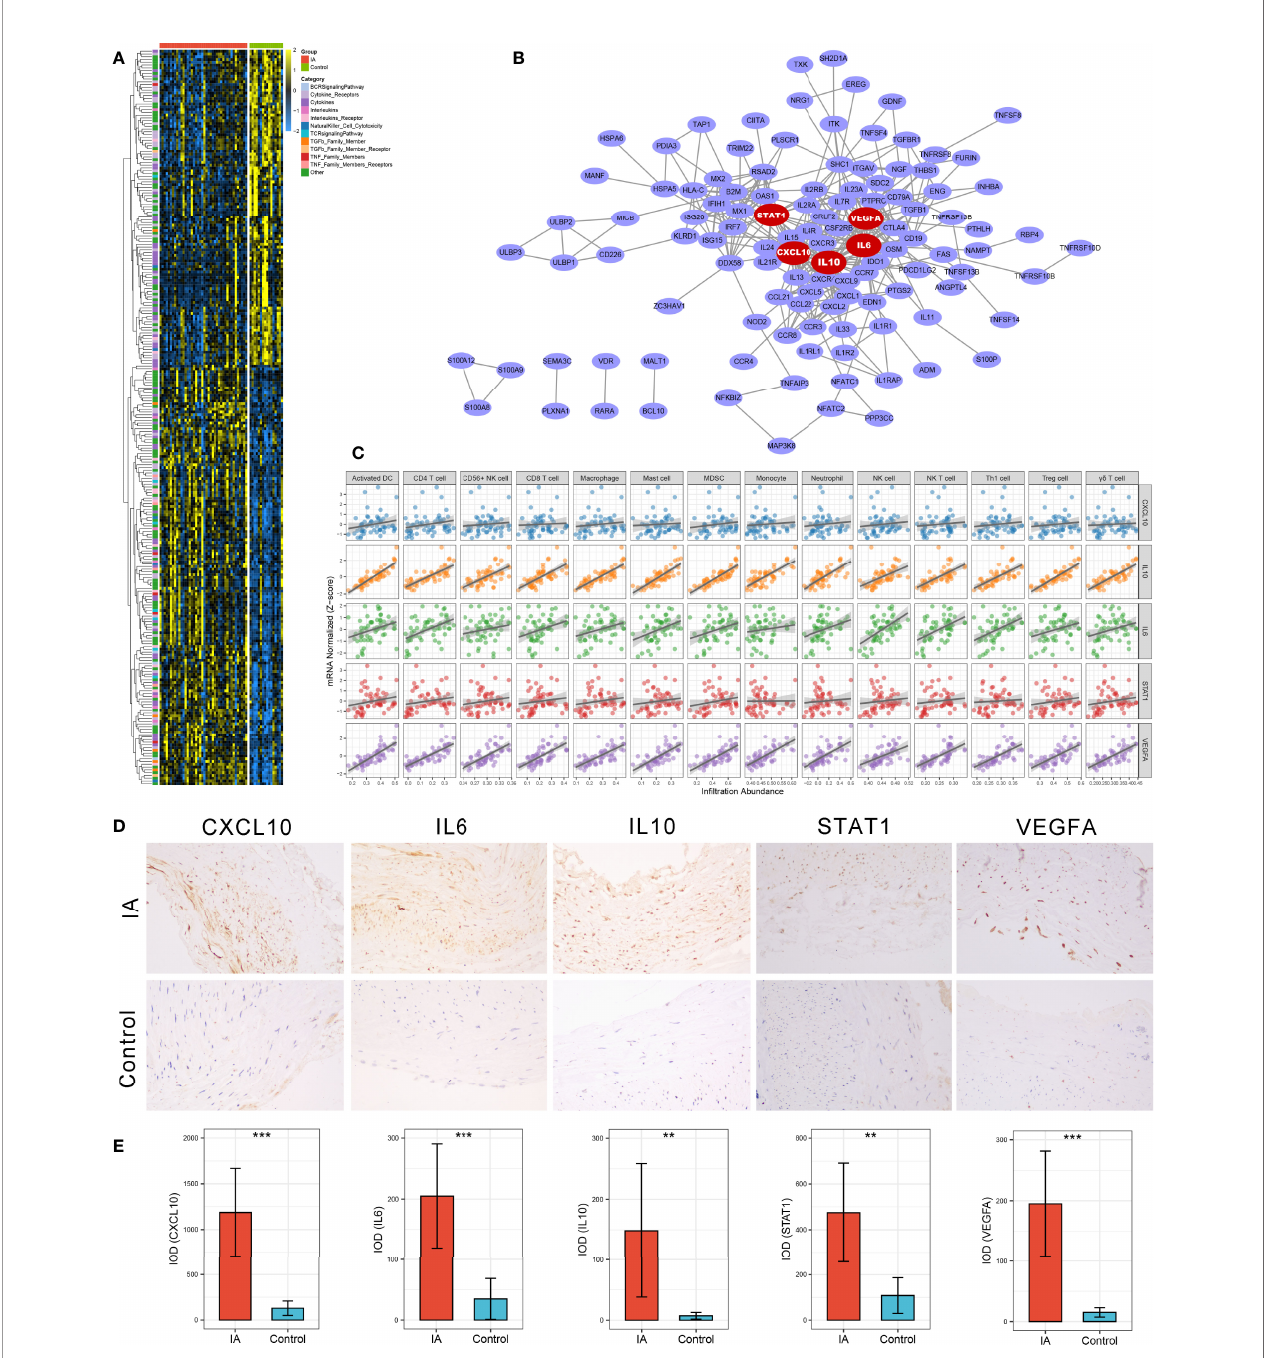
FIGURE 3 | Identi fi cation and validation of immune-related hub genes. (A) Heatmap of 245 immune-related DEGs. (B) Protein-Protein Interaction (PPI) network of upregulated immune-related DEGs. The fi ve red nodes we highlighted in the network were hub genes identi fi ed by cytoHubba-degree algorithm. (C) Correlation analysis of fi ve hub genes and 14 vital immune cells. (D) Representative IHC staining images of CXCL10, IL6, IL10, STAT1, and VEGFA in IAs and STA controls. Magni fi cation, 200×. (E) Comparison of protein expression differences of fi ve hub genes according to IHC results. IOD, integrated optical density. ** P < 0.01, *** P <